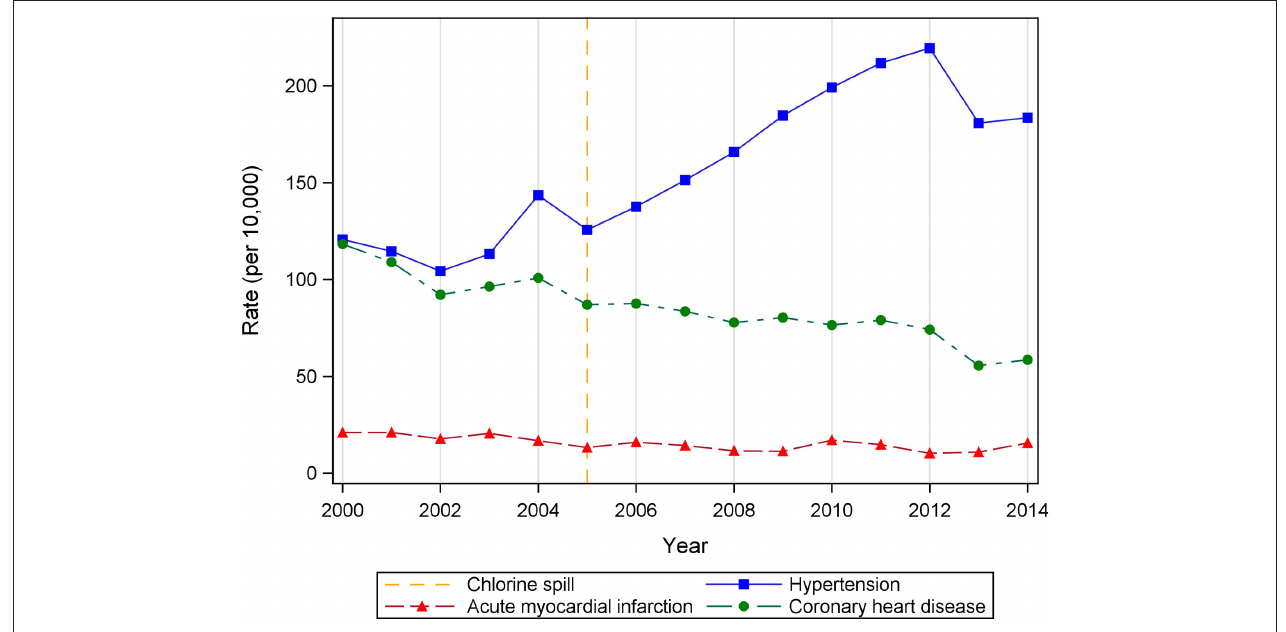
FIGURE 1 | Annual rates of cardiovascular hospital discharges by diagnosis (primary or secondary) among Graniteville-area residents, 2000–2014.